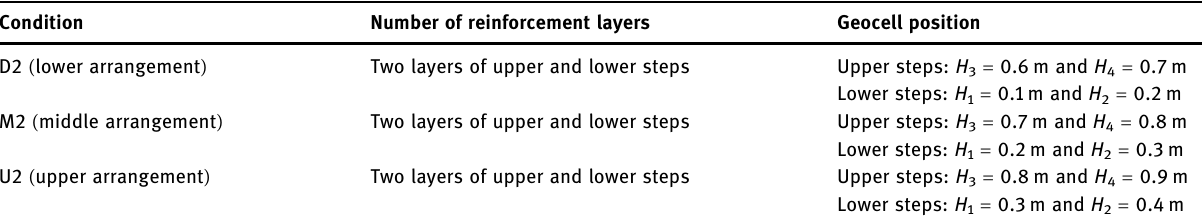
Table 2: Experiment conditions for stepped reinforced retaining walls Condition